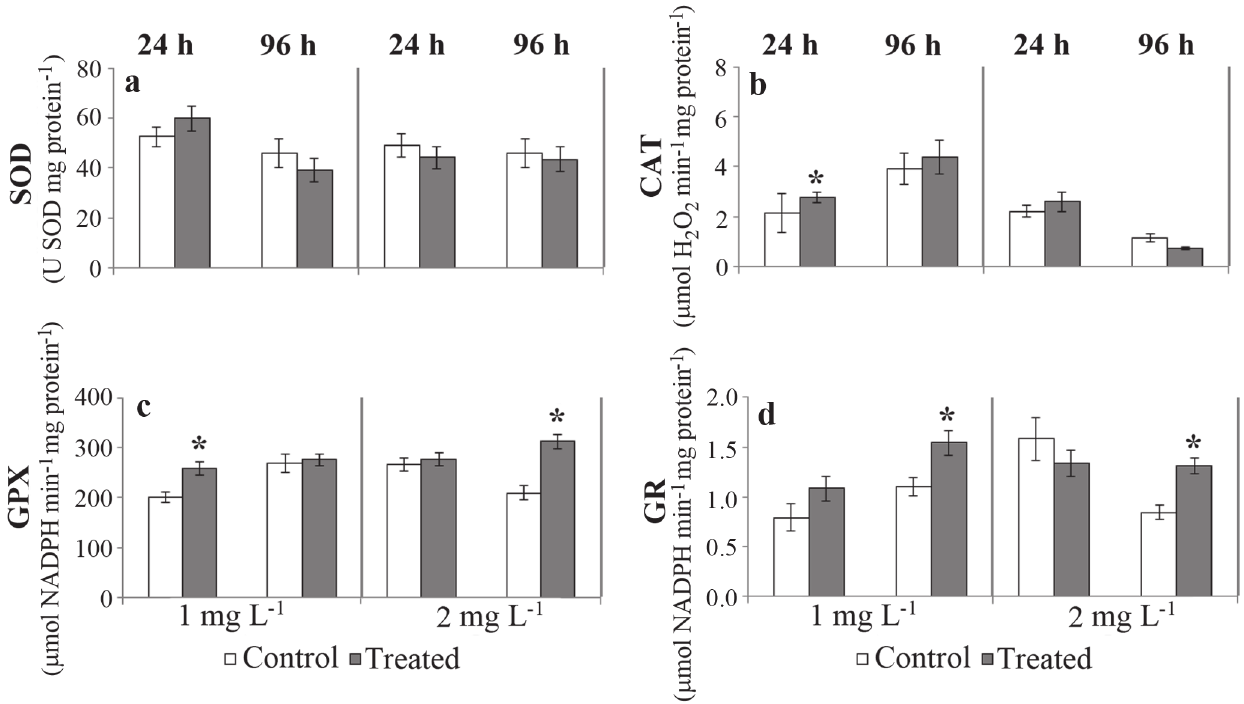
Fig. 3. Activity of superoxide dismutase (SOD; a ), catalase (CAT; b ), glutathione peroxidase (GPx; c ) and glutathione reductase (GR; d ) in gills of Prochilodus lineatus exposed to 1 or 2 mg L -1 lyophilized Microcystis aeruginosa (treated) or only water (control), for 24 and 96 h. Values are presented as mean ± SEM (n = 8). Asterisks indicate significant differences when compared to respective control (p <